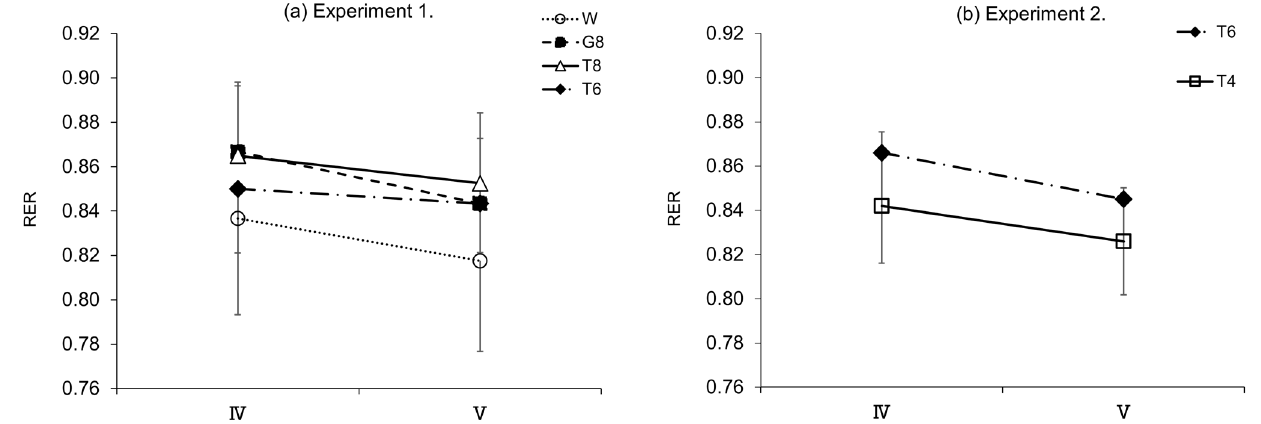
Figure 6. RER assessments. ( a ) Experiment 1 ( n = 12); ( b ) experiment 2 ( n = 10). W, water; G8, 8% glucose; T8, 8% trehalose; T6, 6% trehalose; T4, 4%